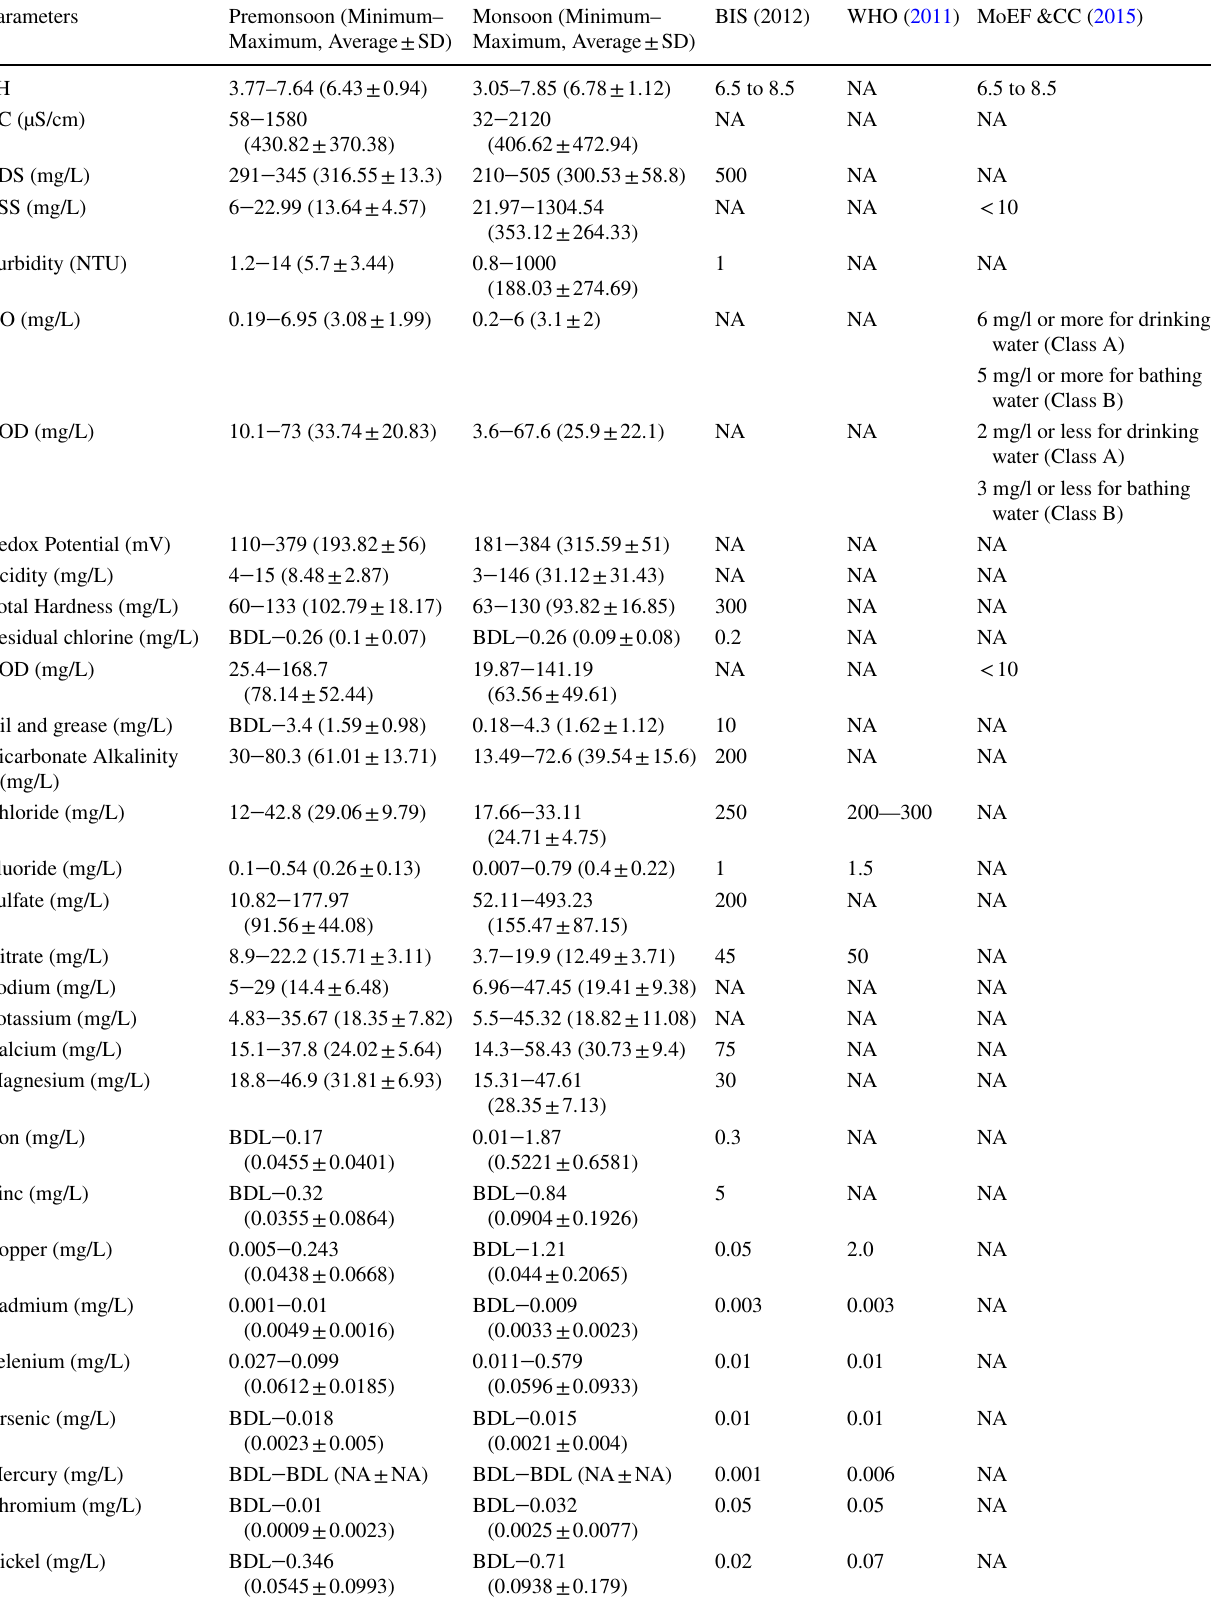
Table 3 Descriptive statistics for concentrations of chemical constituents in premonsoon and postmonsoon samples